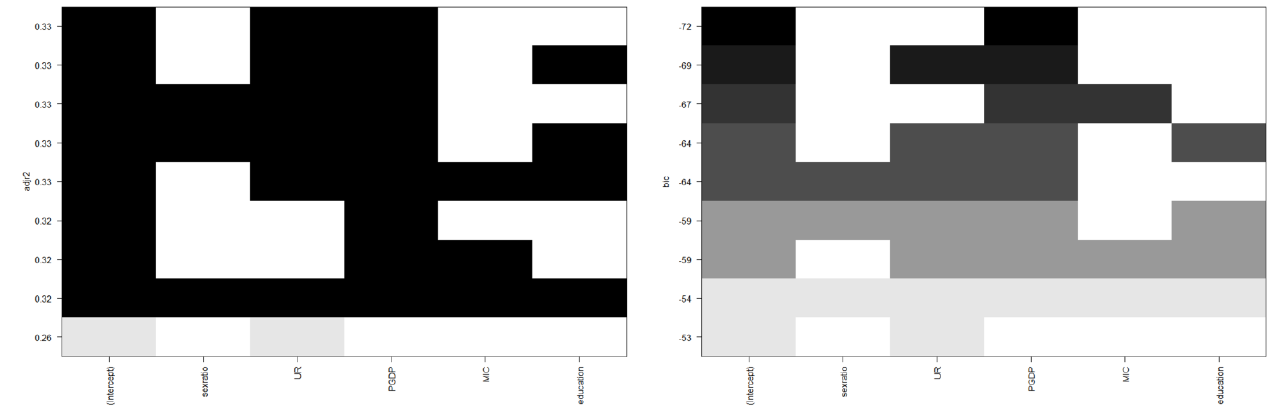
Figure 5. R 2 ( left ) and BIC ( right ) values for models with different socioeconomic factors.